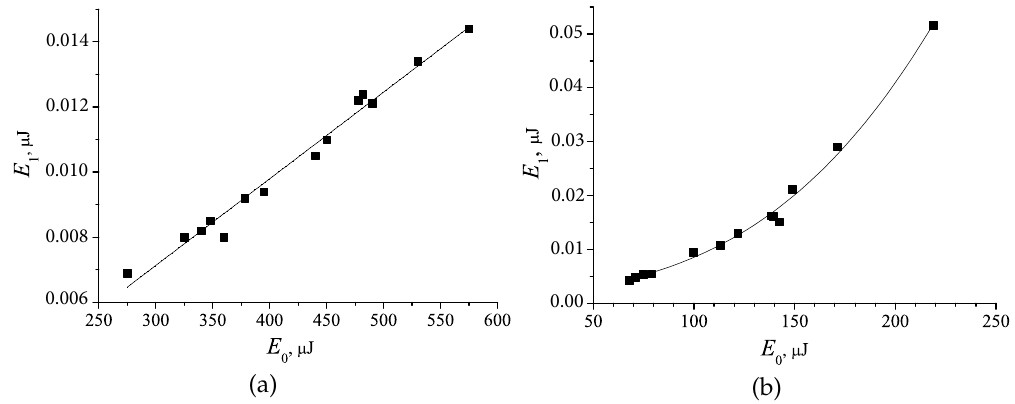
Figure 10. Nonlinear refractometry of Au NP nanocomposites containing Au1 ( a ) and Au2 ( b )